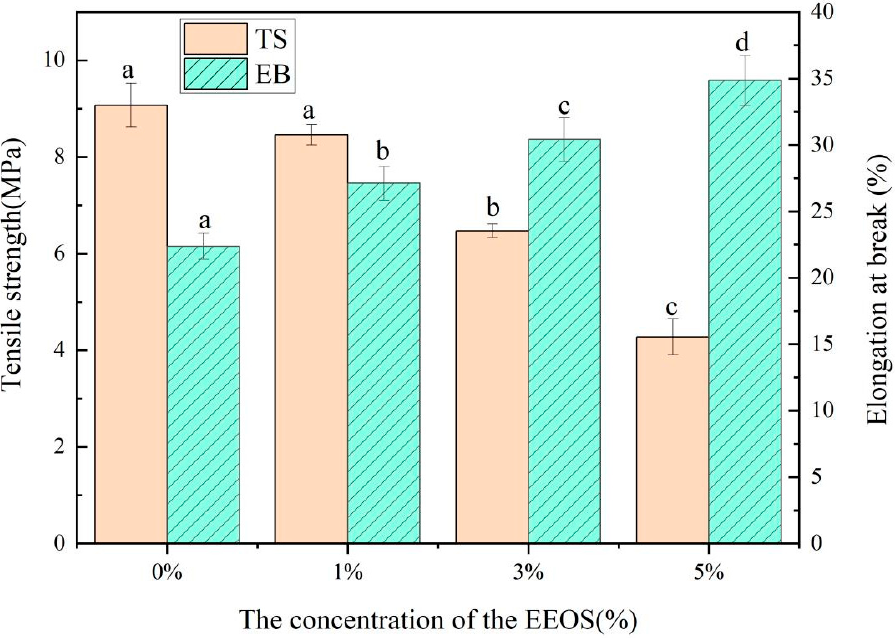
Figure 4. Tensile strength and elongation at the break of the CS/ κ C, CS/ к C/EEOS I, CS/ к C/EEOS II, and CS/ к C/EEOS III composite films. a–d Values are given as means ± standard deviation. Different letters in the same line indicate significant difference ( p < 0.05).